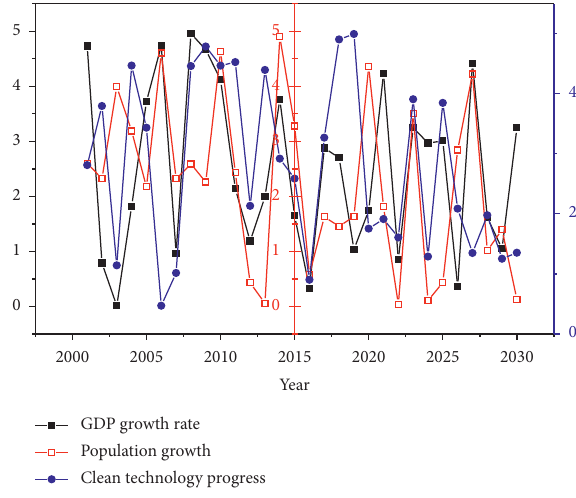
Figure 9: Baseline scenario.